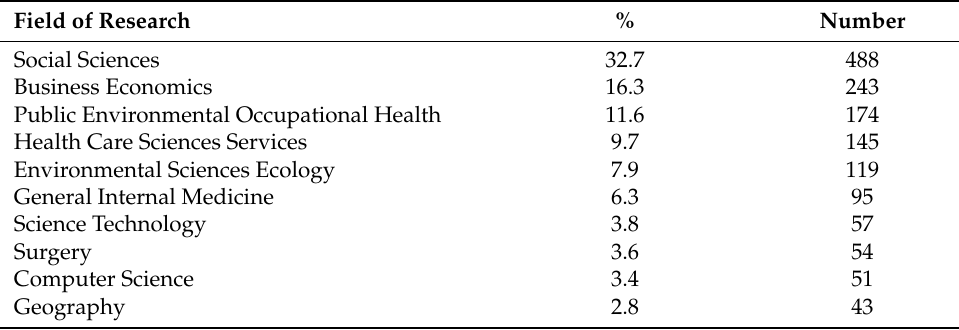
Table 2. Top ten research areas related to health tourism.